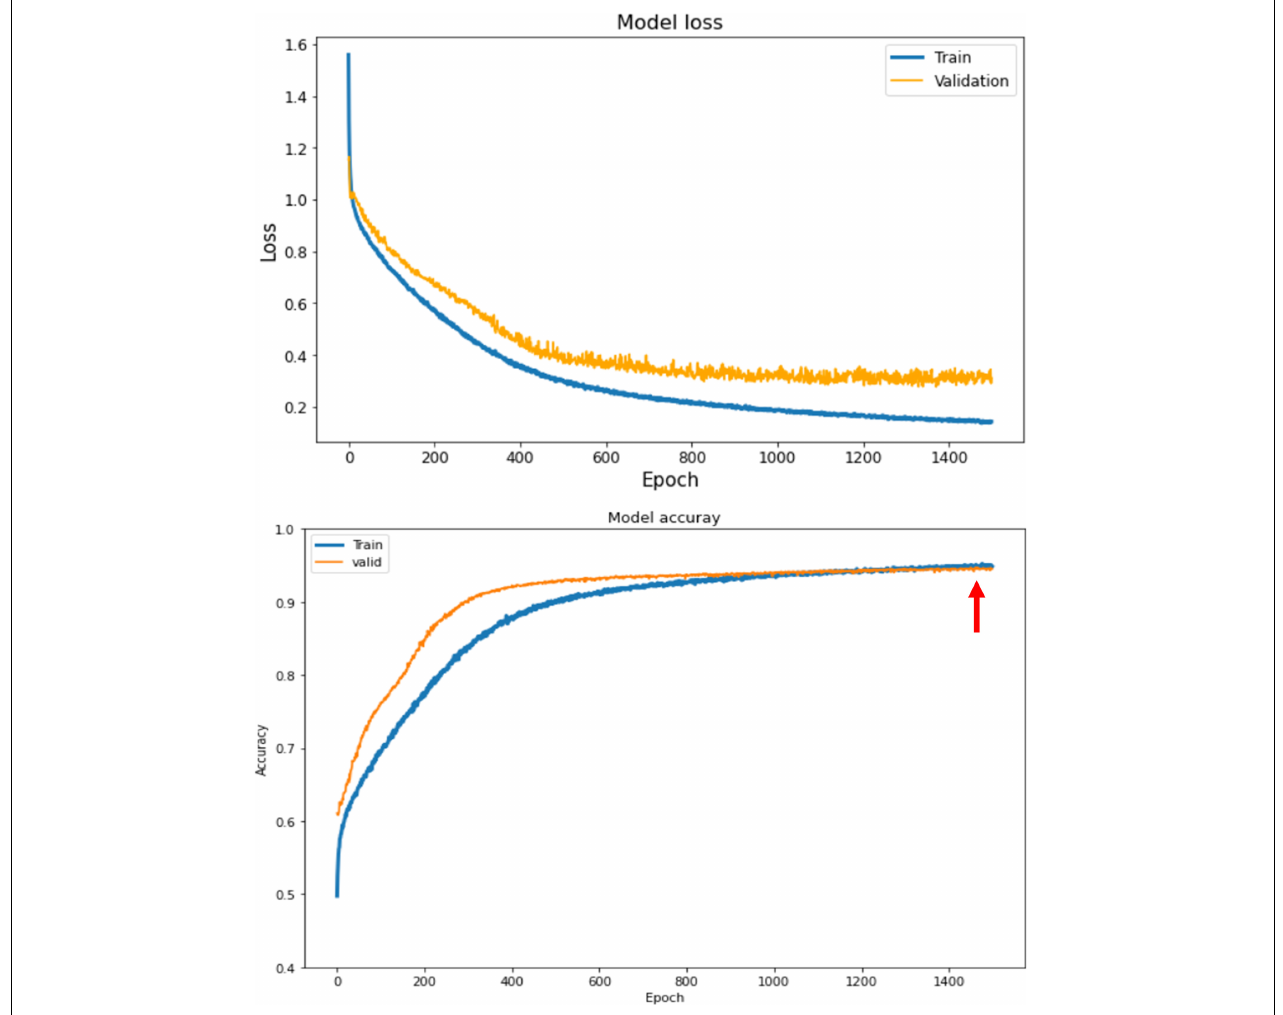
FIGURE 9 | The training history for HBN dataset. The loss (top) and the accuracy (bottom) for train and validation sets. The highest slab-level validation accuracy model happens at epoch 1462 and is shown by the red